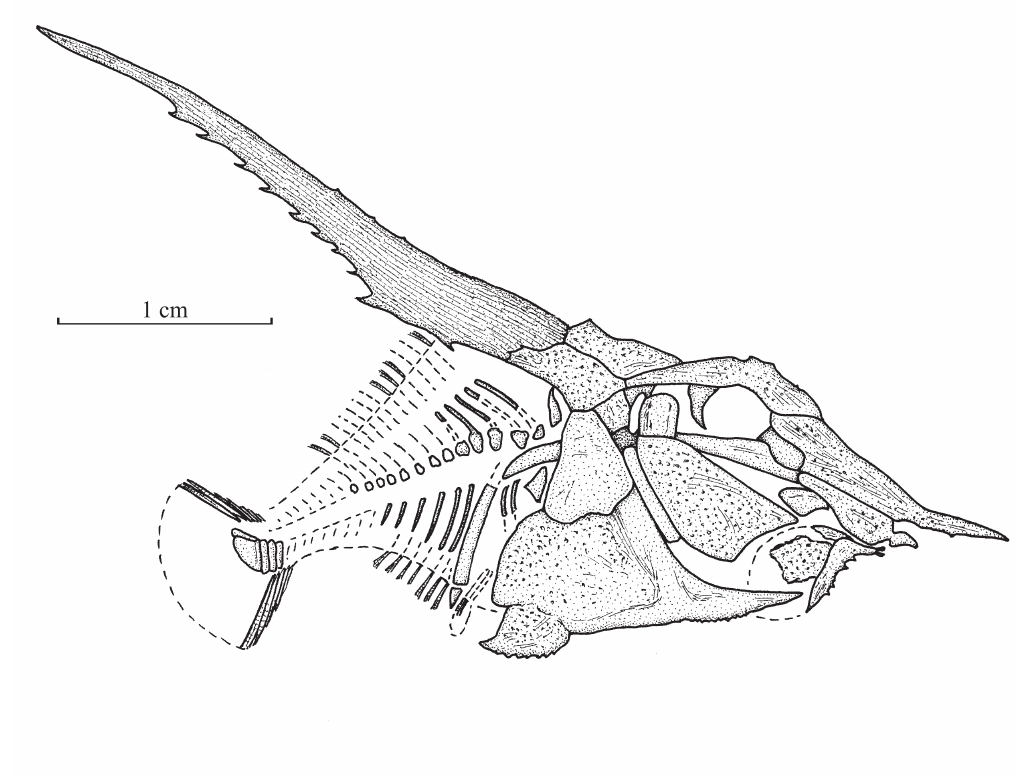
Fig. 18. Pankowskichthys libanicus gen. et sp. nov. General reconstruction based on holotype, IRSNB P